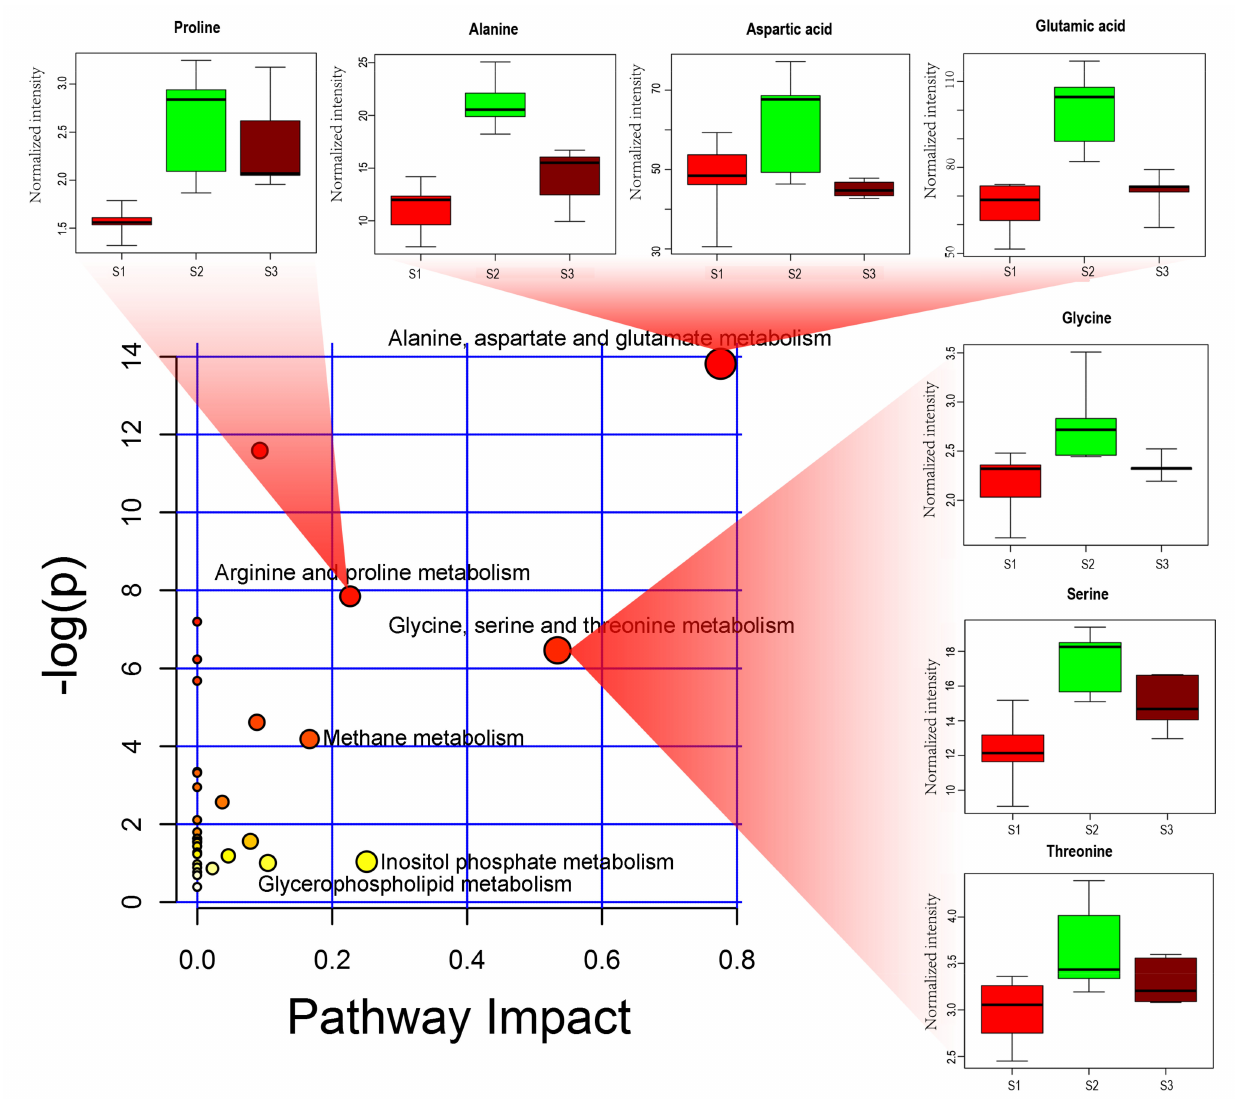
Figure 3. Pathway analysis shows the impact of different metabolisms and the change of compounds in amino acid metabolism. The y-axis boxplots (–) indicate the median values, the top/bottom ranges of the boxes indicate the upper/lower quartiles, and the top/bottom whiskers indicate the maximum/minimum distribution of the data. The boxes across the x-axis from left to right indicate the tea shoots of S1 (red), S2 (green) and S3 (brown), respectively (for interpretation of the references to color in this figure legend, the reader is referred to the web version of this